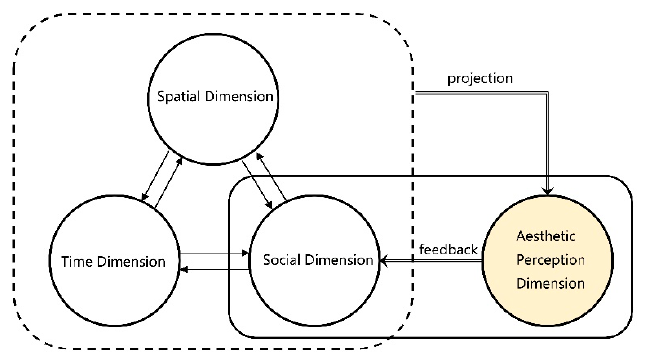
Figure 1. Multidimensional Iterative Relationship of Urban Landscape.